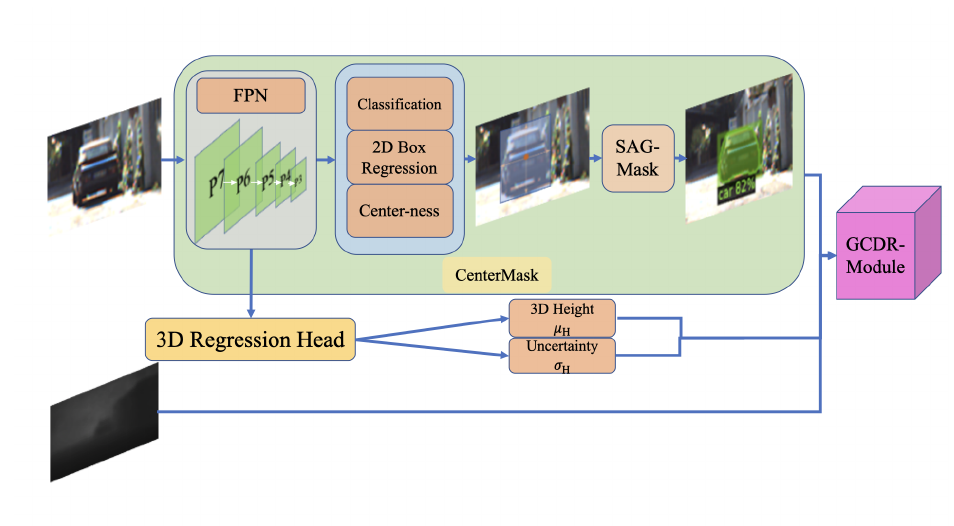
Figure 5. The complete object-guided depth refinement module. Our module takes an image as input, along with the original depth map, 3D height and uncertainty generated from the added 3D regression head. All is feed into our GCDR module for further depth refinement.